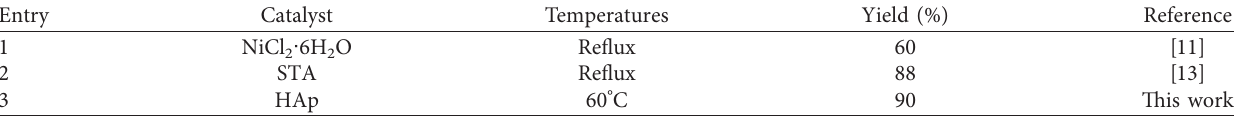
Table 4: Comparison of HAp with other catalysts for the synthesis of fully functionalized pyrrole derivatives.